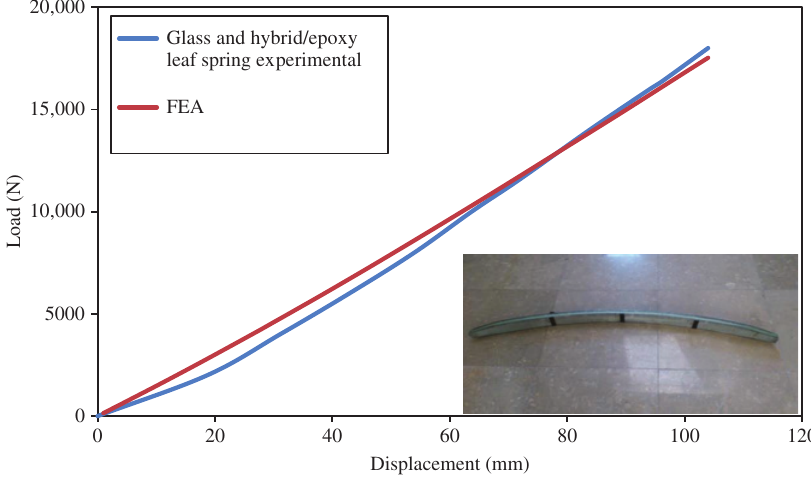
Figure 18: Predicted and experimental load-displacement response of Prototype